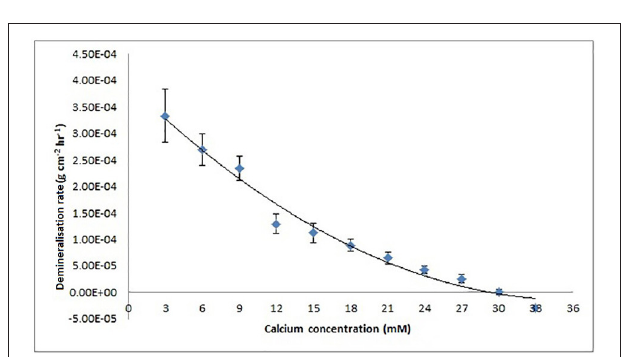
FIGURE 3 | Typical SMR showing the linear changes in projected mineral mass of enamel with time and the 95% confidence intervals ( p ≤ 0.0001) in 0.1M acetic acid solution at pH = 4.0.